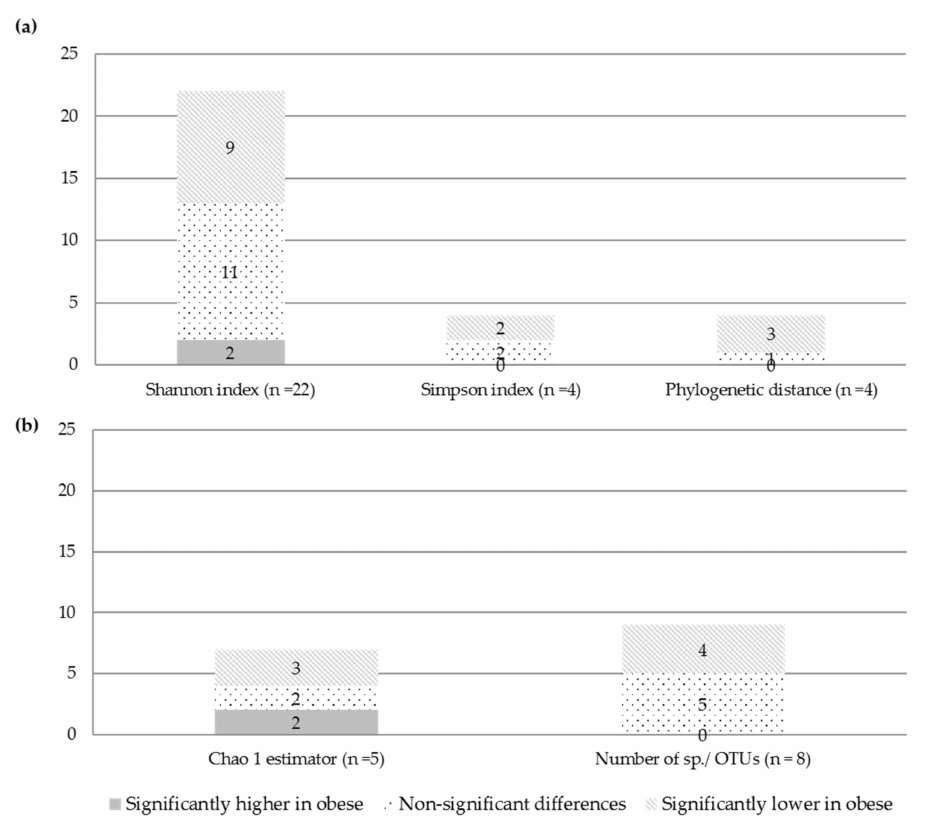
Figure 3. Number of studies that reported alpha diversity indices Panel ( a ) or richness estimators Panel ( b ) as significantly higher (grey), lower (diagonal stripes) or not different (dotted) when comparing obese to non-obese